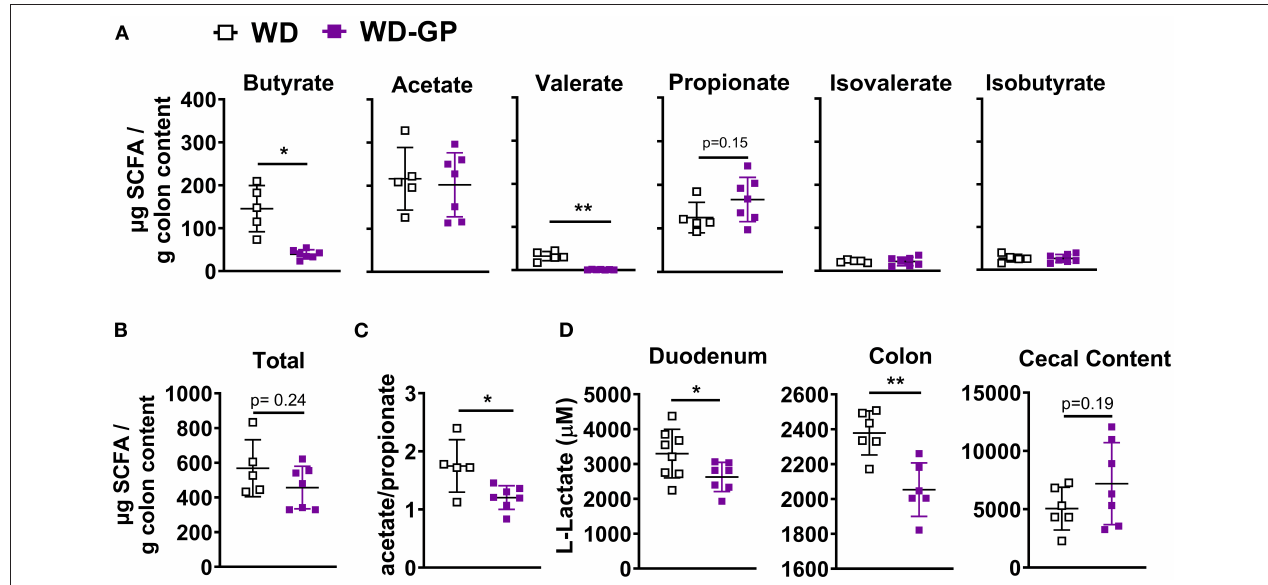
FIGURE 4 | GP supplementation decreased intestinal concentrations of specific SCFAs and lactate. (A) Concentrations of individual SCFAs and BCFAs in colon content. (B) Total SCFA and BCFA concentration. (C) Ratio of acetate to propionate. (D) Lactate concentrations in duodenum and colon tissues and in cecal content. Data are presented as mean ± SD. Significant difference was determined by unpaired, two-tailed, t -test with Welch’s correction; * p < 0.05, ** p <